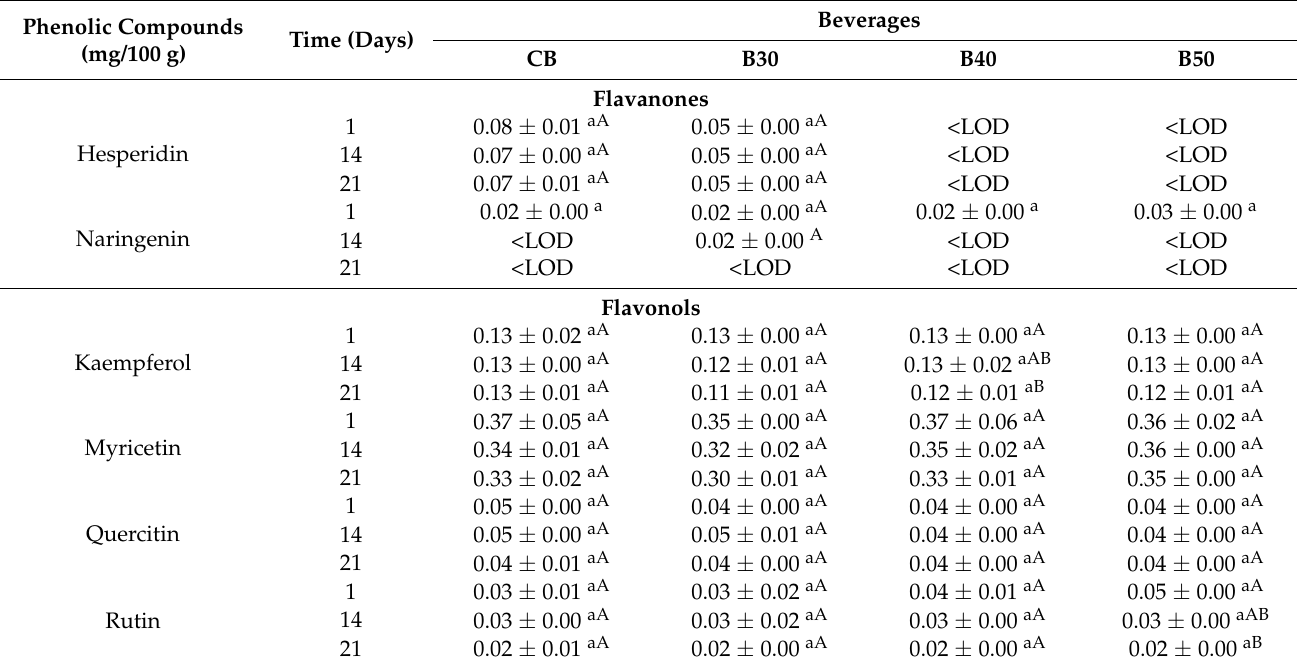
Table 4. Phenolic compounds (mean ± standard deviation) identified in formulated beverages during 21 days of refrigera- tion storage (4 ◦